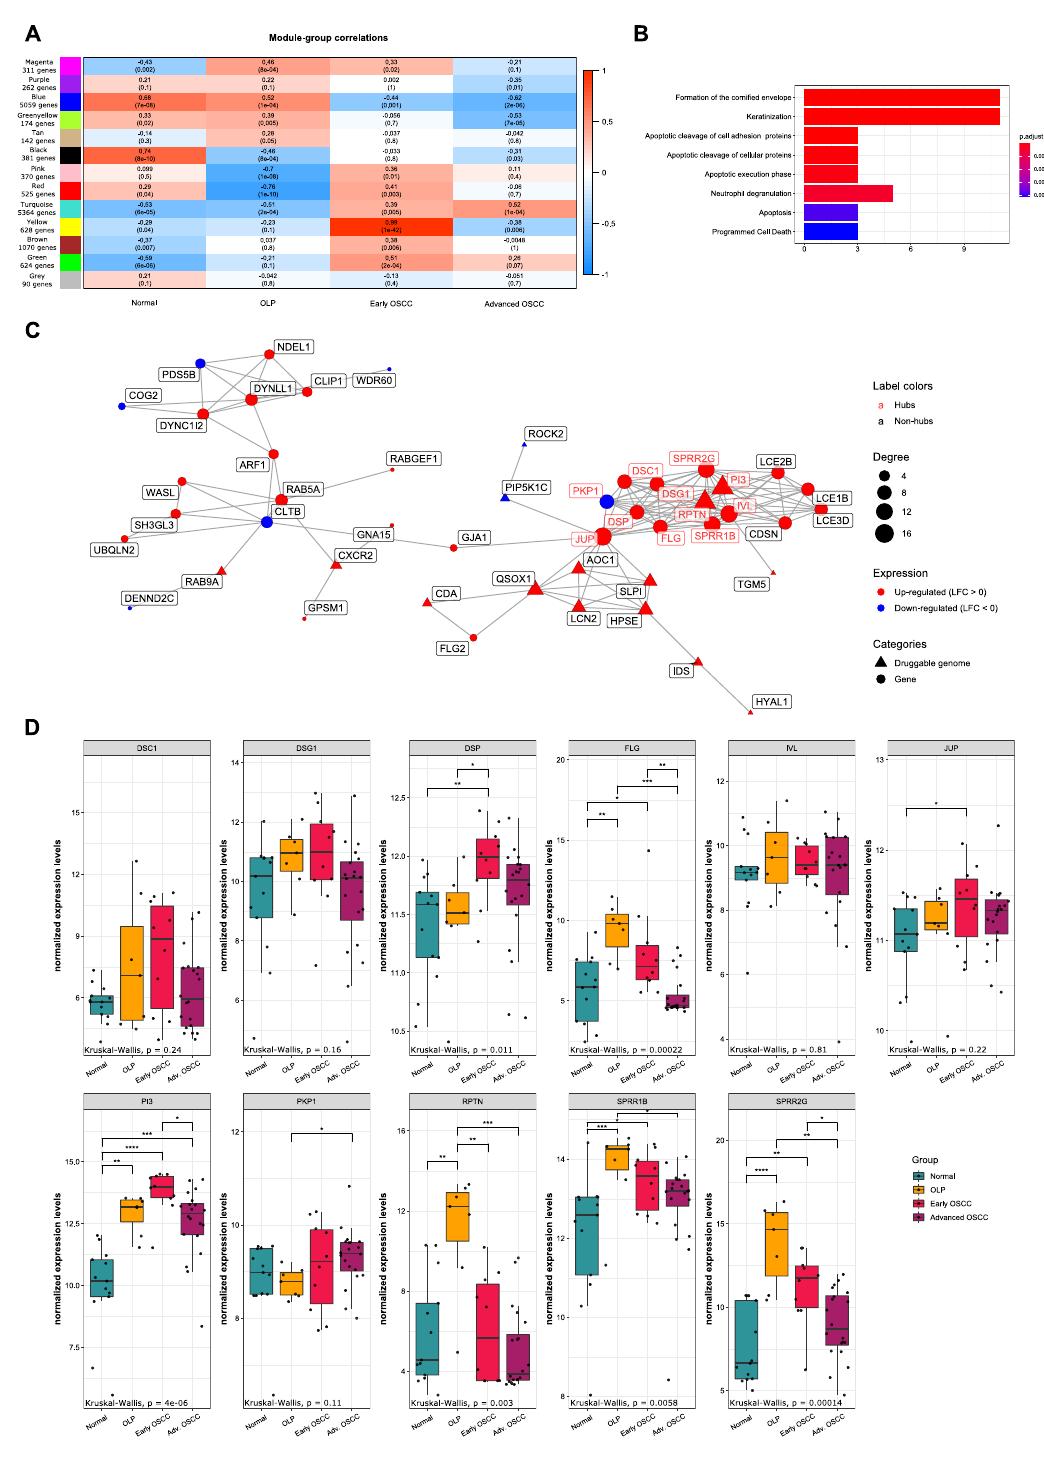
Figure 3. Analysis of co-expressed genes and their regulation. ( A ) Correlations between the co-expression modules and each of the sample groups (normal tissue, OLP, early OSCC, and advanced OSCC). Cell colors correspond to Pearson correlation values between each co-expression module (rows) with groups (columns), from blue (100% inverse correlation) to red (100% direct correlation). Numbers in each cell refer to Pearson’s correlation r values, with p-values represented below in parentheses. Correlations with p < 0.05 were considered statistically significant. ( B ) Pathway enrichment of genes in the magenta module using ORA. All represented pathways are significantly enriched (FDR > 0.05). Bar length and colors indicate gene counts and BH-adjusted p-values, respectively. ( C ) Representations of the magenta module as a PPI network (largest connected component). Node size, shape, and color represent degree, category, and LFC in OLP, respectively. Red node labels indicate hubs. ( D ) Hub genes from the magenta module compared between OLP, both OSCC groups, and normal tissue. Box plots represent the normalized expression distribution in each group. Comparisons among groups were made using the Kruskal–Wallis test followed by Dunn’s post-hoc test, with p-values lower than 0.05 considered significant for both tests. *p < 0.05; **p < 0.01; ***p < 0.001; ****p <